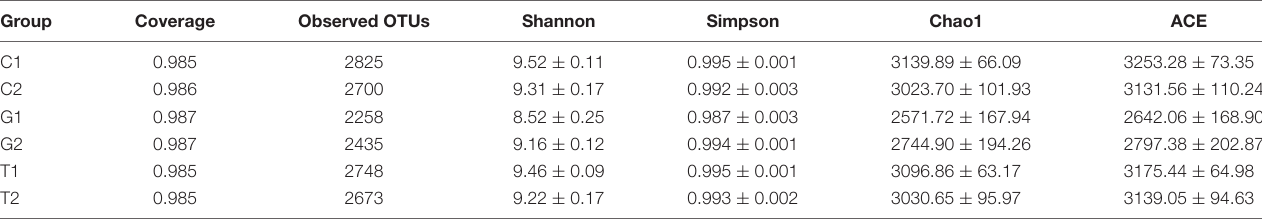
TABLE 2 | Alpha diversity indices of soil microbial communities in different soil